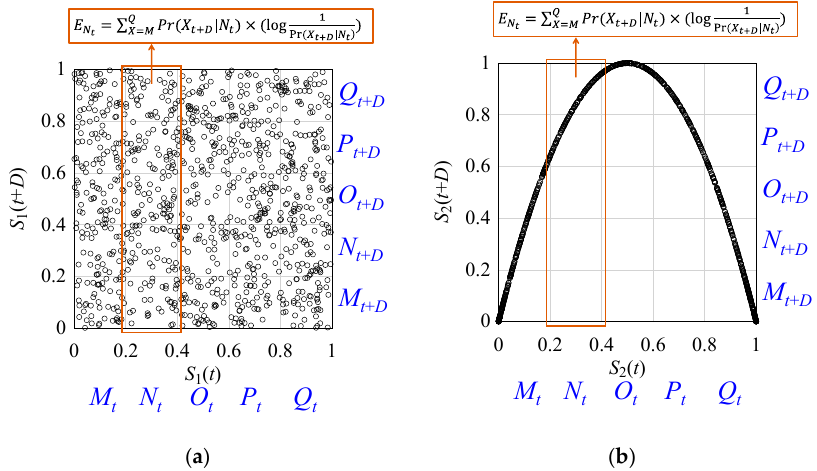
Figure A1. The concept of calculating entropy of information underlying the delay maps of: ( a ) S 1 and ( b ) S 2. The abovementioned transition probabilities create an entity defined as the Transi- tion Probability ( Pr ) Matrix ( TM ) as follows.